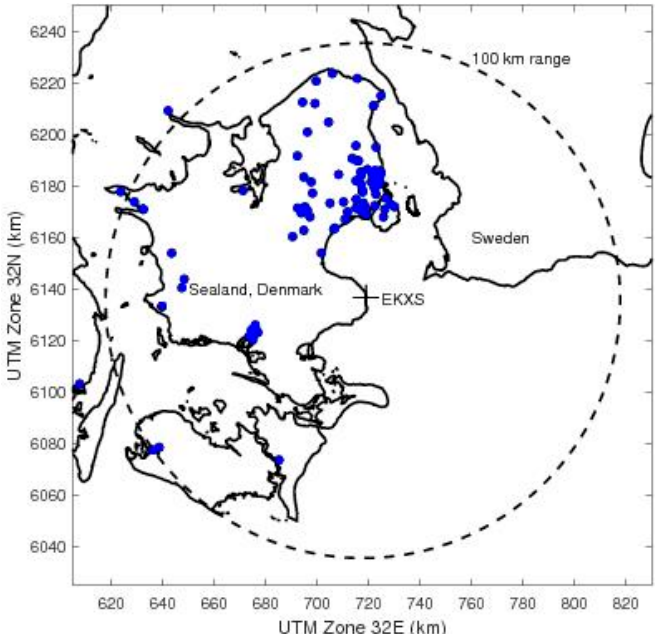
Figure 1. Domain of radar (EKXS) rainfall dataset and rainfall stations/gauges (blue dots) used of bias adjustment of radar data.